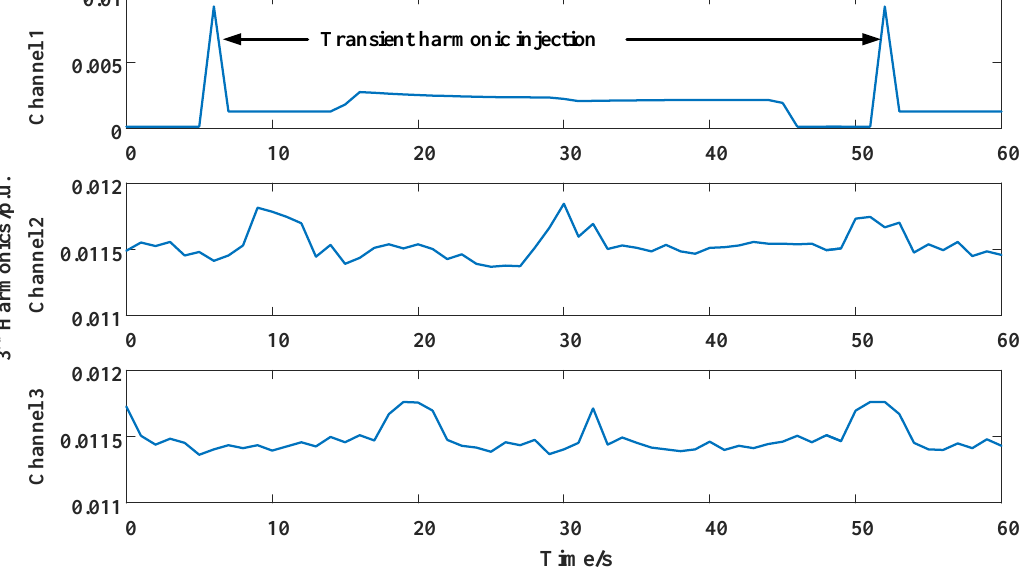
Figure 11. Third current harmonics of 3 typical channels at the same PCC with transient harmonic injection in Channel